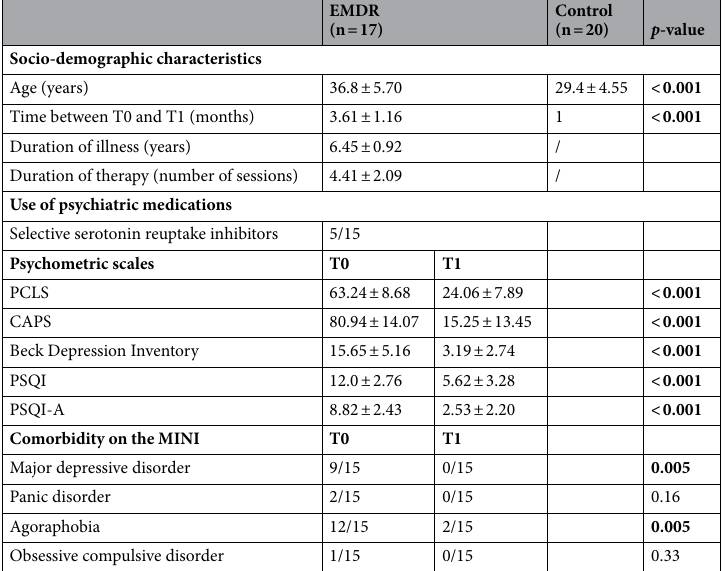
Table 1. Socio-demographic and clinical characteristics of individuals with post-traumatic stress disorder receiving eye movement desensitization and reprocessing (EMDR) therapy and controls. Values are mean ± SD. Significant p-values are in bold. PCLS Posttraumatic Stress Checklist Scale, CAPS Clinician-Administered PTSD Scale, PSQI Pittsburgh Sleep Quality Index, PSQI-A PSQI-Addendum for PTSD, MINI Mini- International Neuropsychiatric